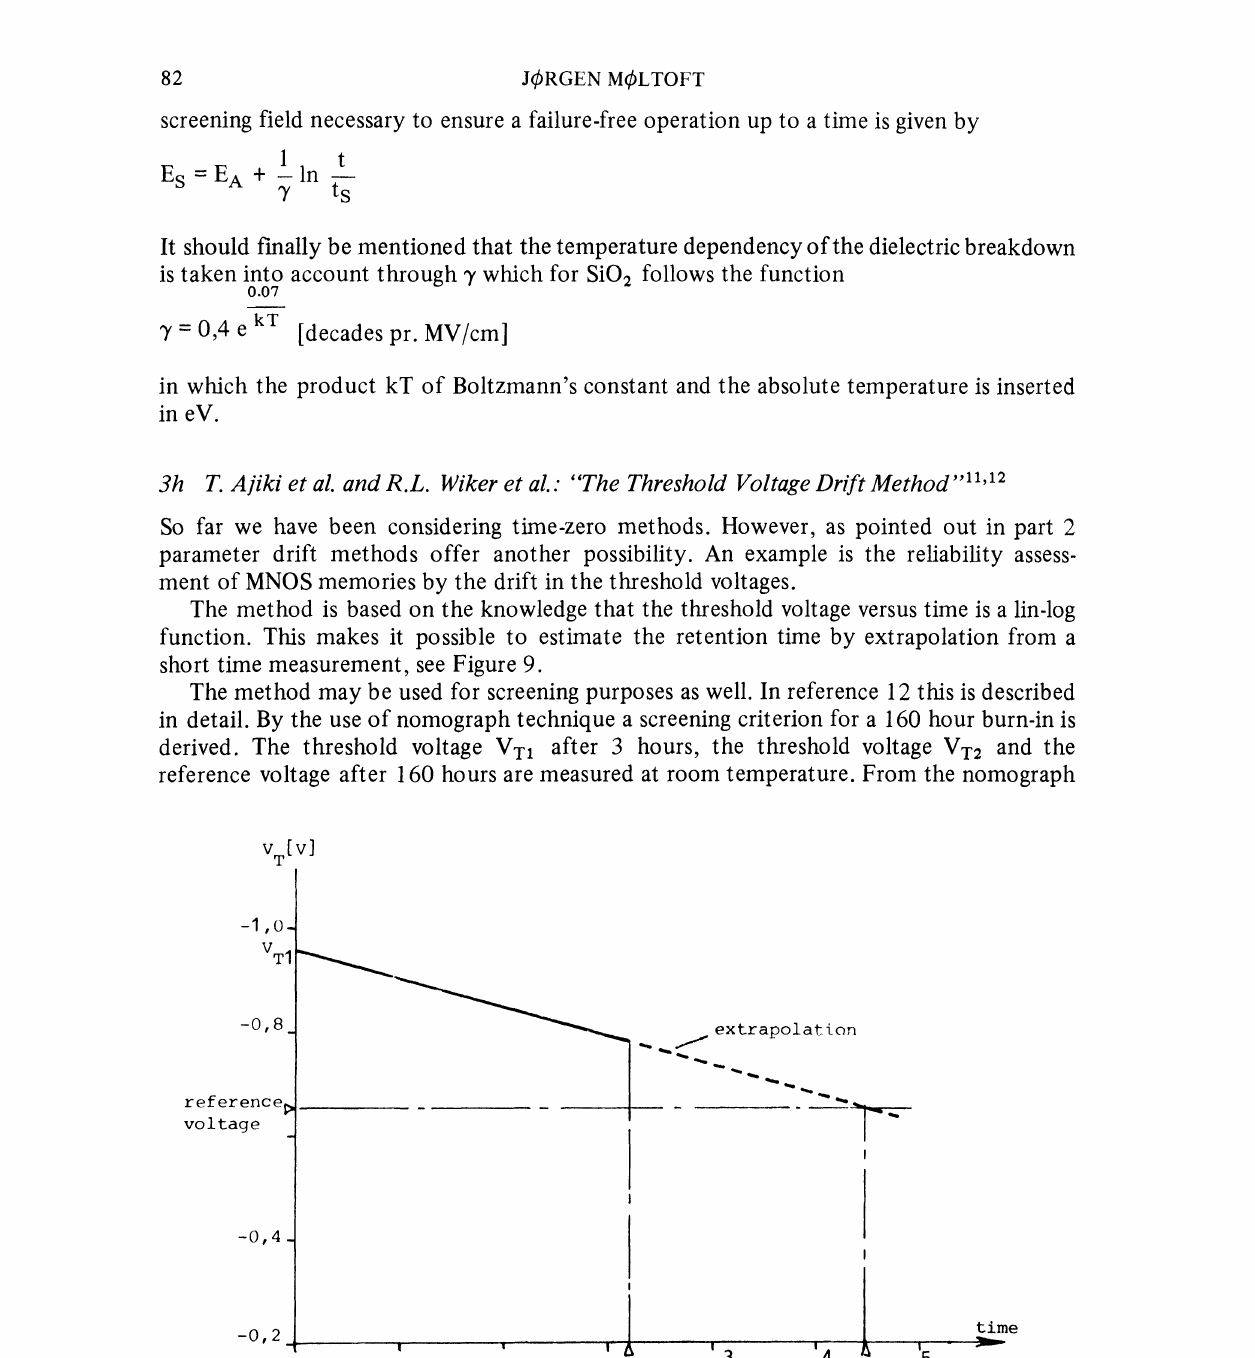
FIGURE 9 (from ref.